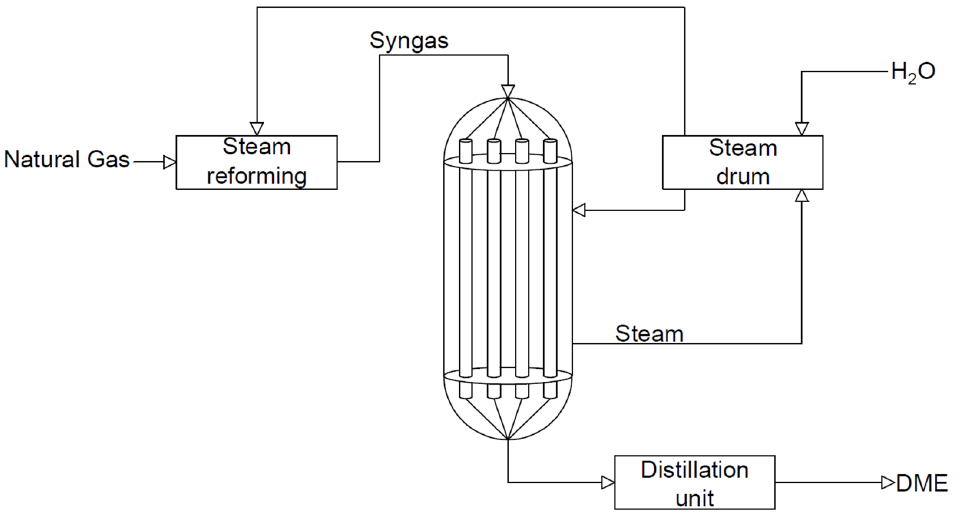
Figure 11. Scheme of an isothermal adiabatic reactor (perspective of dimethyl ether). Developed based on